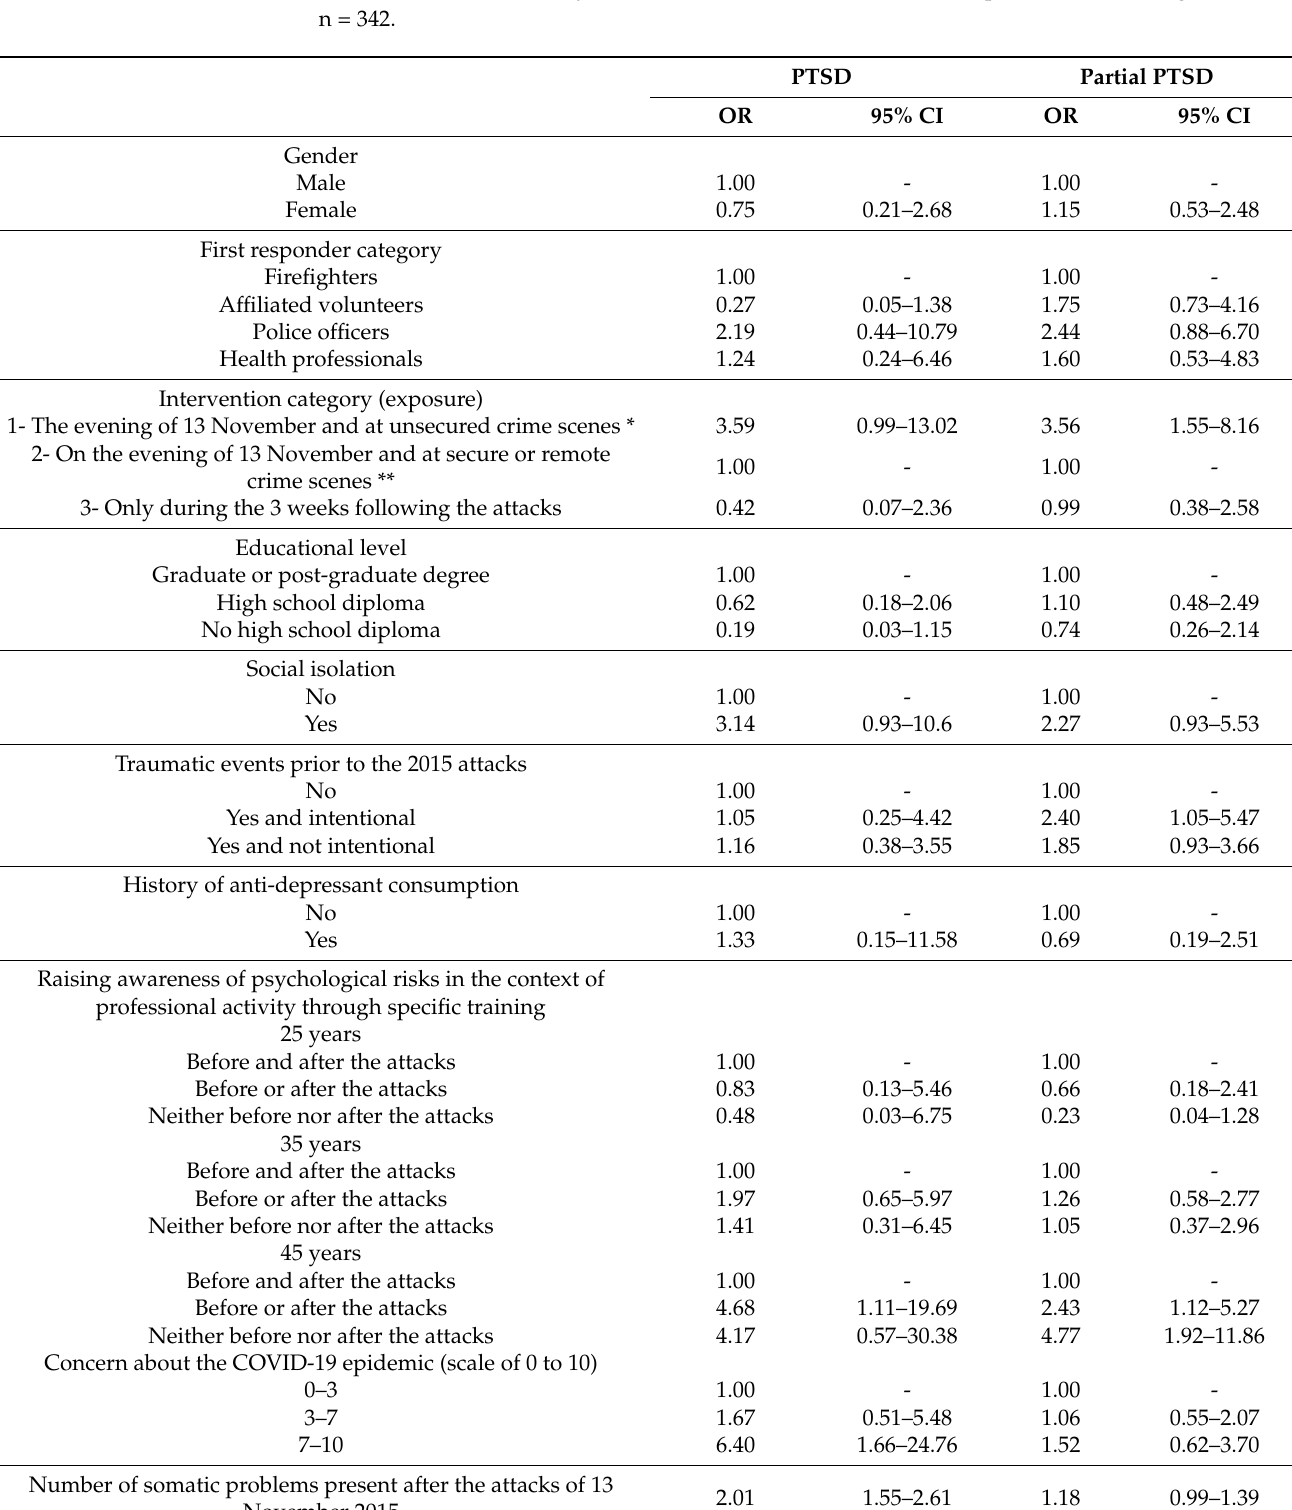
Table 3. Multivariate analysis of factors associated with PTSD and partial PTSD among wave 2 FR, n =